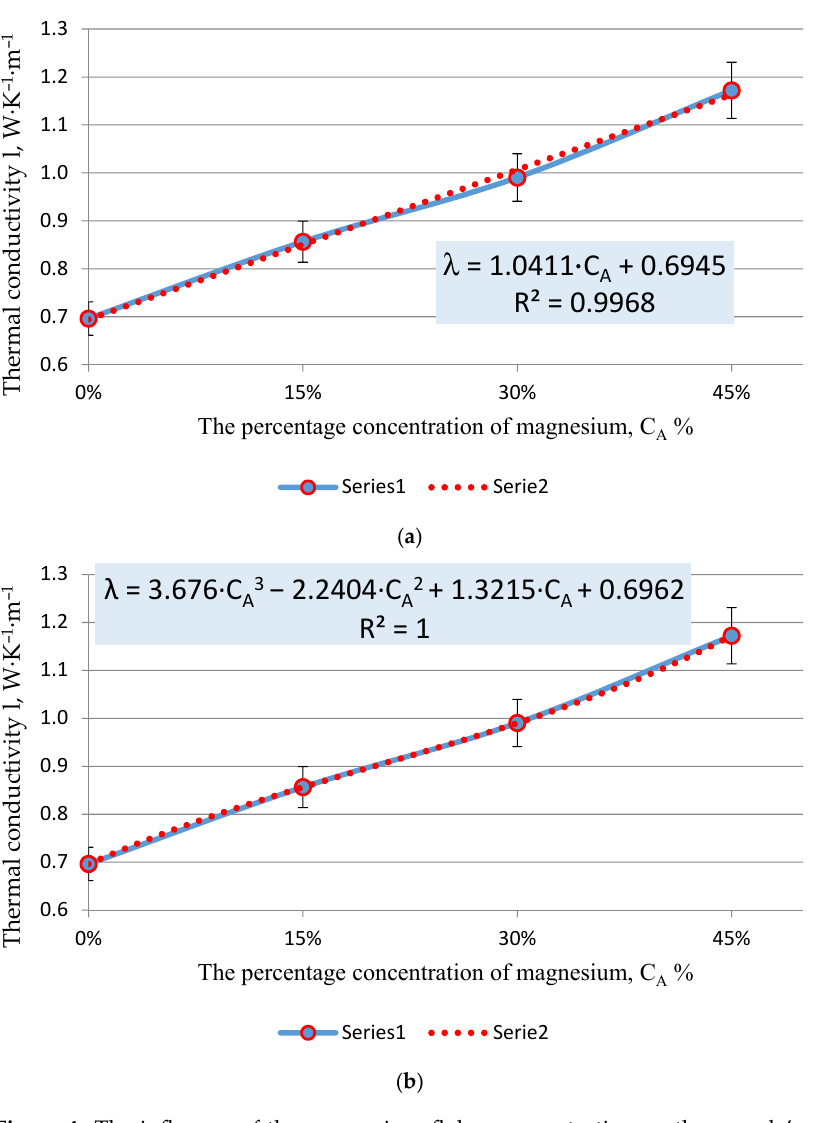
Figure 4. The influence of the magnesium flakes concentration on the sample’s average thermal conductivity values: ( a ) trend line as a linear function, ( b ) trend line as a polynomial function; Series 1—graph based on the measurement results, Serie 2—trend line. Table 3. Thermal conductivity test results for the base sample.